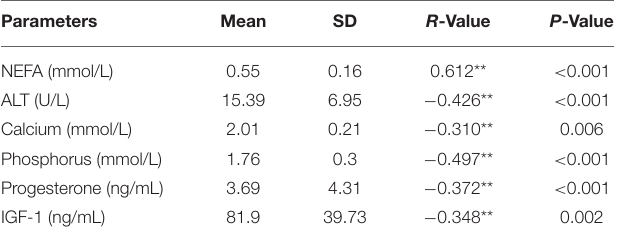
TABLE 3 | Correlation between plasma biochemical indexes and ovarian diseases in dairy cows ( n = 76). Parameters Mean SD R -Value P -Value 0.55